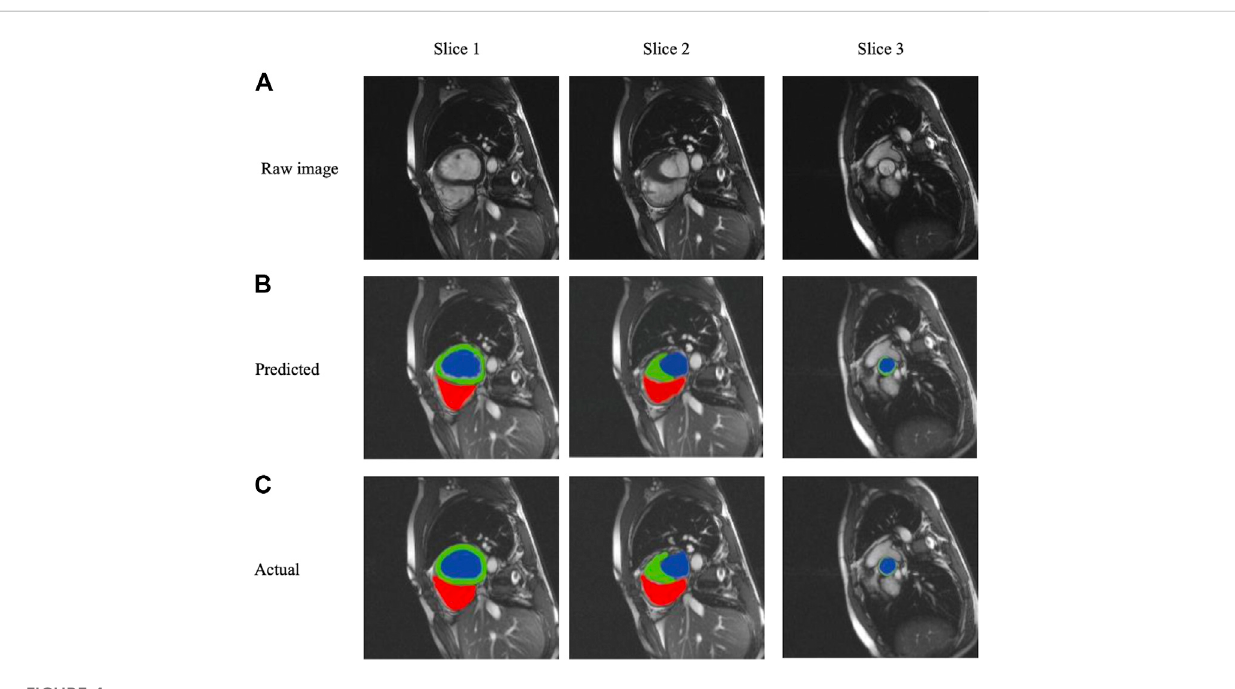
FIGURE 4 Segmentationresultsfromanalysisofthethreesliceheartsamplesbasedon (A) rawimages, (B) Predicted segmentationimages,and (C) Actualgold standard segmentationimages; redareasrepresent therightventricle, green areasrepresent themyocardium,andblueareasrepresenttheleftventricle.